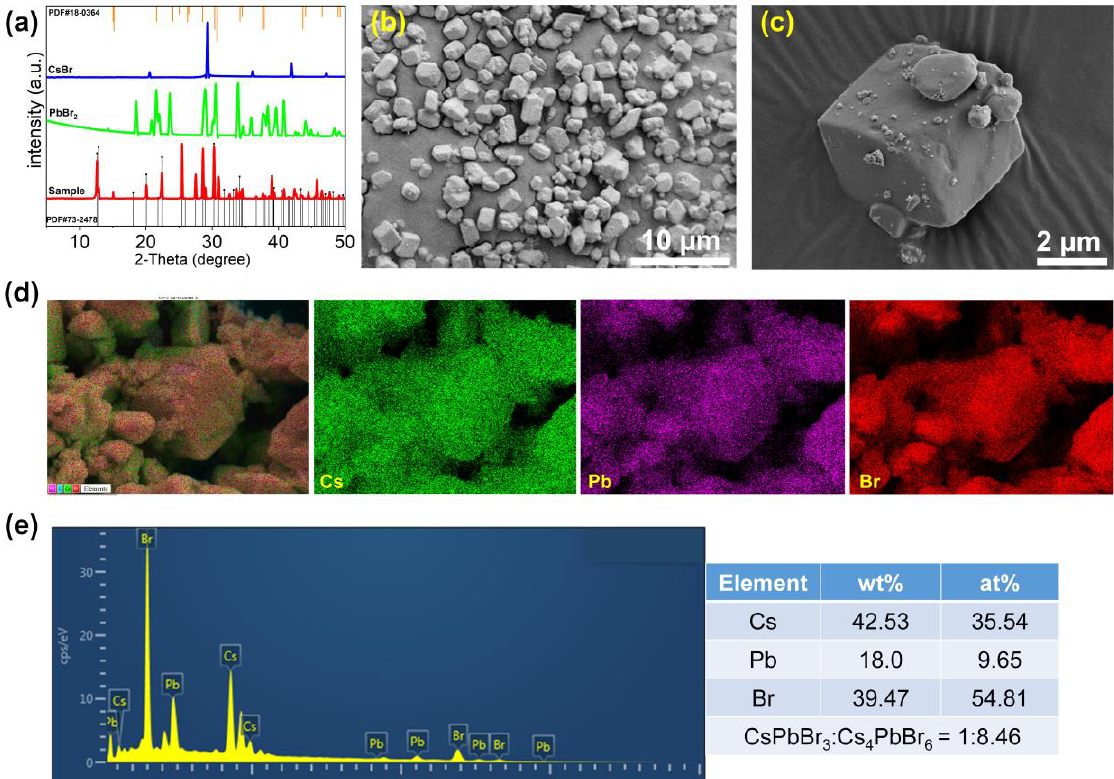
Figure 2. Structure phase and morphological characterization of the as-prepared samples: ( a ) XRD patterns (red lines represent experimental data, and other lines represent standard reference); ( b ) SEM image, scale bar 10 µ m; ( c ) high-resolution SEM image (HR-SEM), scale bar 2 µ m; ( d ) averaged EDX elemental mapping (green for Cs, purple for Pb, and red for Br) of a small selection of as-obtained samples; ( e ) EDS spectrum and atomic